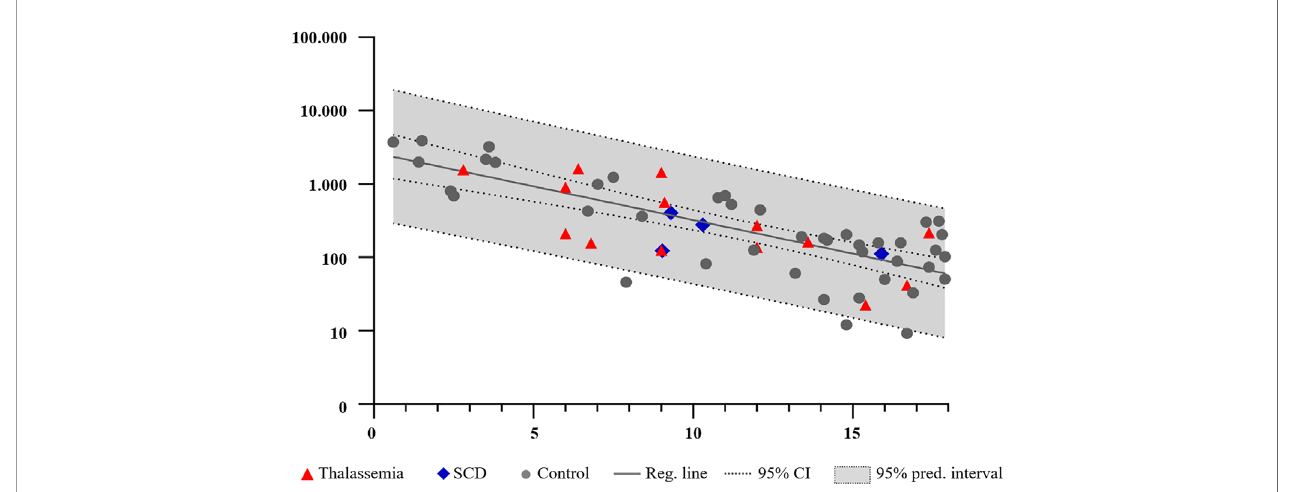
FIGURE 2 | Follicle density (follicles/mm 3 ) in normal ovaries (gray circles) and in girls and adolescents with thalassemia (red triangles) and sickle cell disease (SCD) (blue diamonds) (plotted against age. Soled line indicates the predicted follicle density; dotted line indicates the 95% con fi dence intervals (CI), and the gray area the 95% prediction